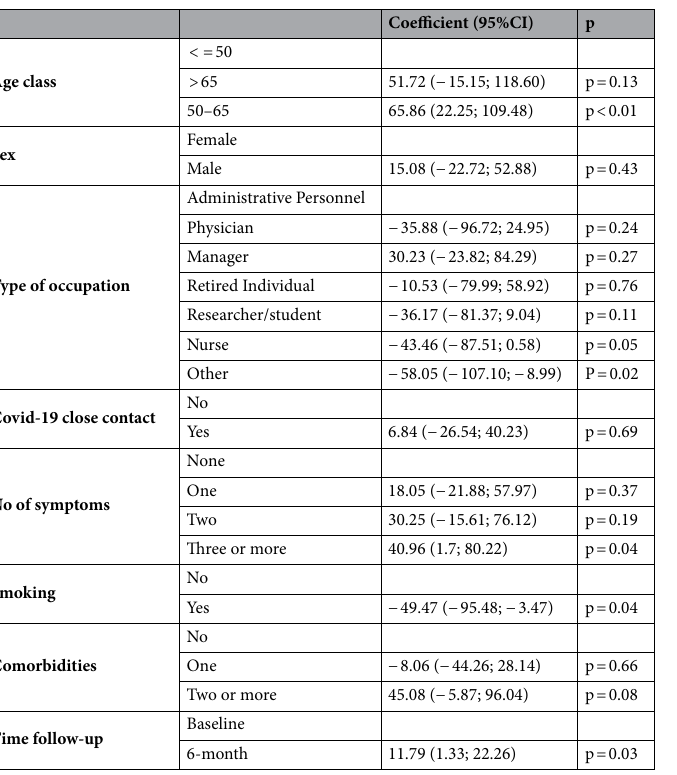
Table 2. Multilevel multivariable quantile regression on quantitative antibody levels of positive cases at baseline retested at 6 months. Value (95% CI, p-value) represents mean change (95%CI, p-value) in the median of antibody levels associated to each covariate, adjusted for all the